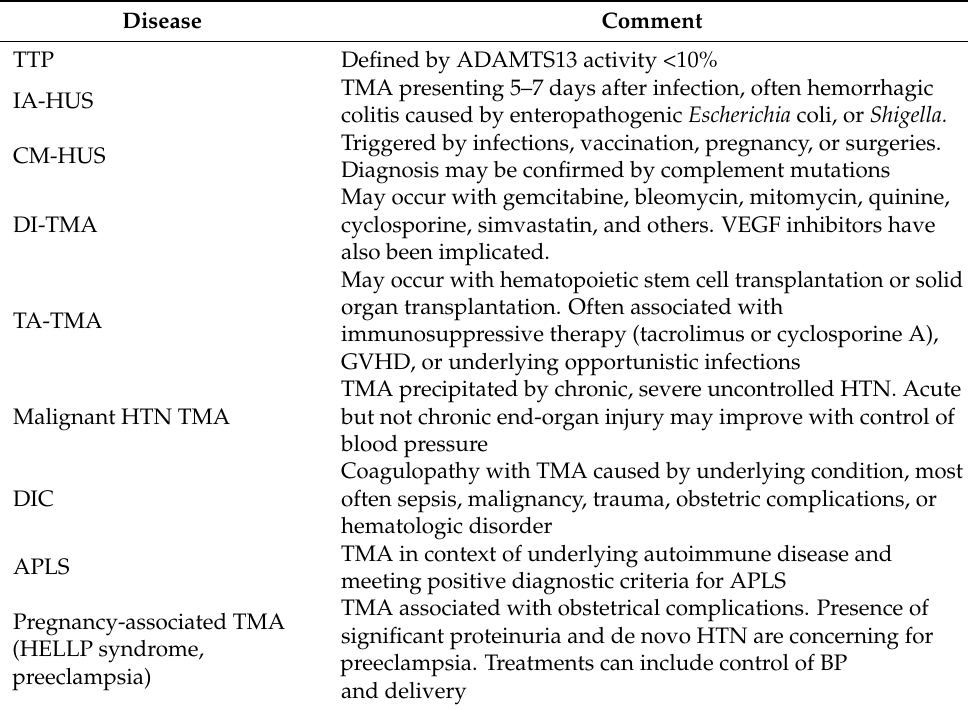
Table 1. Differential diagnosis for patients presenting with MAHA-T